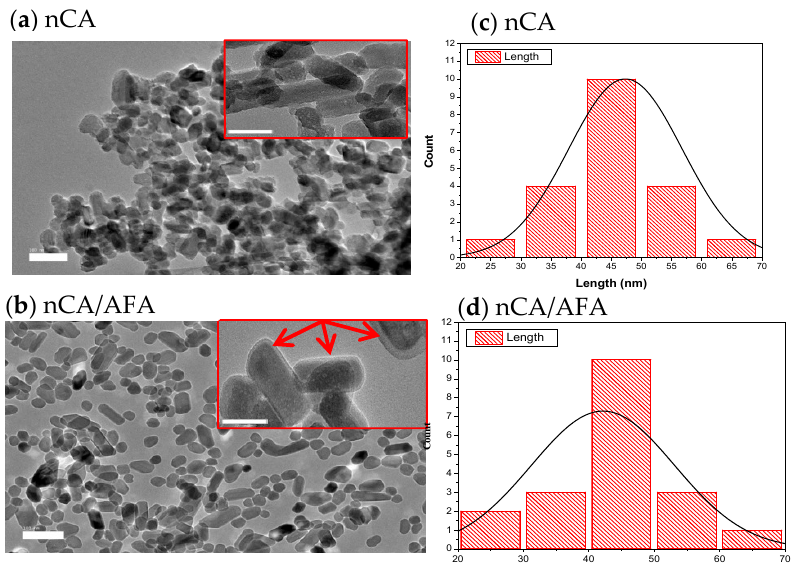
Figure 4. HR-TEM images. ( a , b ) HR-TEM micrographs of nCA and nCA/AFA with a scale bar of 100 nm. Each image inset has a scale bar of 20 nm, and the red arrow confirms the encapsulation of the drug into the nCA. ( c , d ) Histogram of nCa and nCA/AFA size as measured by HR-TEM (Gaussian distribution size).